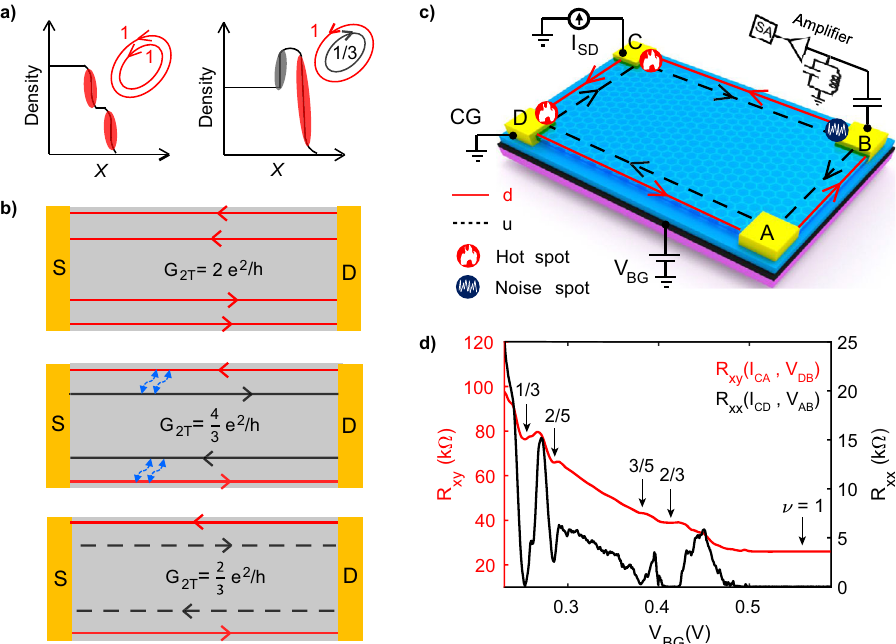
Fig. 1 Edge pro fi le, Device schematic, Hot spot, Noise spot, and QH response. a Left panel: density pro fi le at the edge of a sample with co-propagating mode structure for ν = 2, giving rise to two-terminal conductance of G 2 T = 2 e 2 / h (cf. the top panel of ( b )). Right panel of a : density pro fi le at the edge of a sample with counter-propagating mode structure for ν = 2/3, giving rise to the two-terminal conductance G 2 T = (4/3) e 2 / h for sample length L < l C l C is the charge equilibration length (cf. the middle panel of ( b )). Here, X is the coordinate across the edge. The bottom panel of b shows the structure of a eq ν = 2/3 edge for l C < L < l H , where l H is the thermal equilibration length, giving rise to G 2 T = (2/3) e 2 / h with a downstream mode of conductance (2/3) e 2 / h eq eq eq and a charge-neutral upstream mode. The downstream charge modes are represented by the red solid lines, while the upstream charge mode is the black solid line and the charge-neutral upstream is the black dashed line in panel ( b ). The blue wiggly lines in the middle panel of b represent the interaction between the counter-propagating modes. c Schematics of the device and measurement setup, where the device is set into ν = 2/3 FQH state. A noiseless dc current is injected at contact C and terminates into the cold ground (CG) contact D. The upstream mode carries the heat from the hot spot (where the energy is dissipated) near the contact C and reaches the noise spot close to contact B. The noise at this contact is then measured at a frequency of ~763 kHz using an LCR resonance circuit followed by ampli fi er chain and spectrum analyzer. d Transverse Hall resistance ( R xy ) and longitudinal resistance ( R xx ) of the device-1 at 10